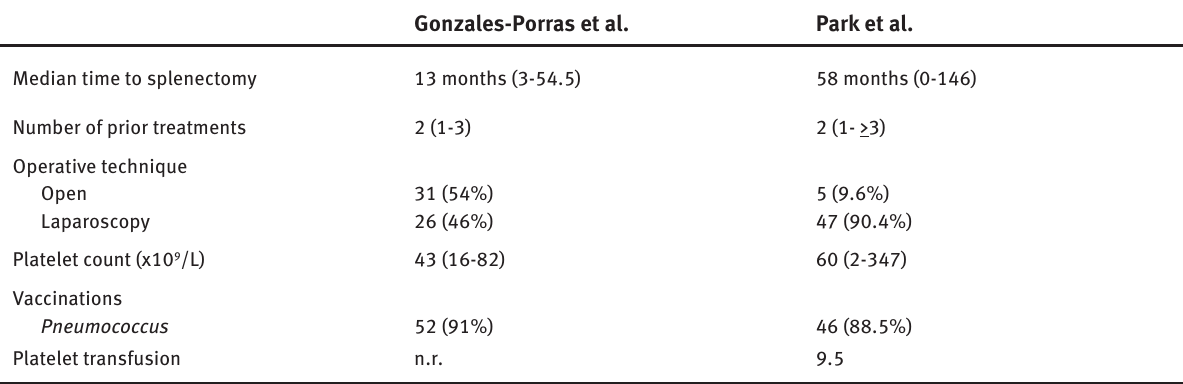
Table 3: Preoperative characteristics